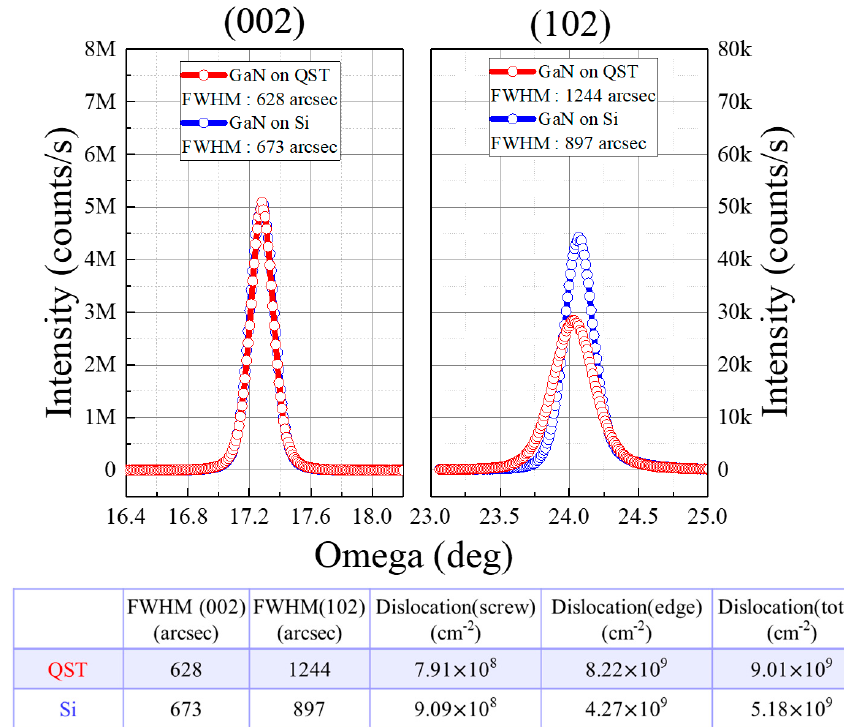
Figure 2. XRD results and total dislocation of the GaN on QST and